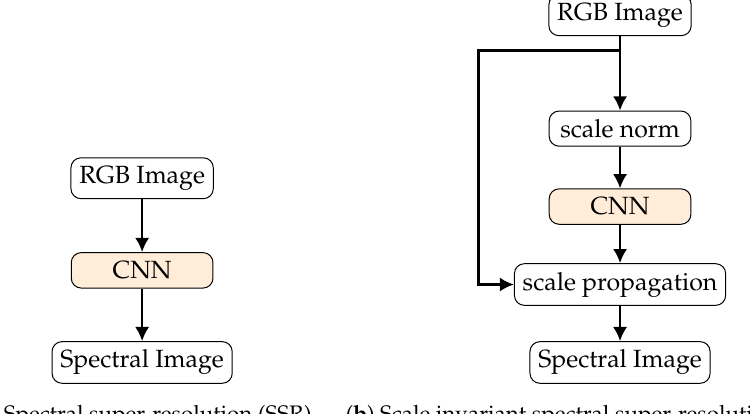
Figure 3. Visualization of the proposed workflow for achieving scale invariance using deep learning based spectral spectral reconstruction